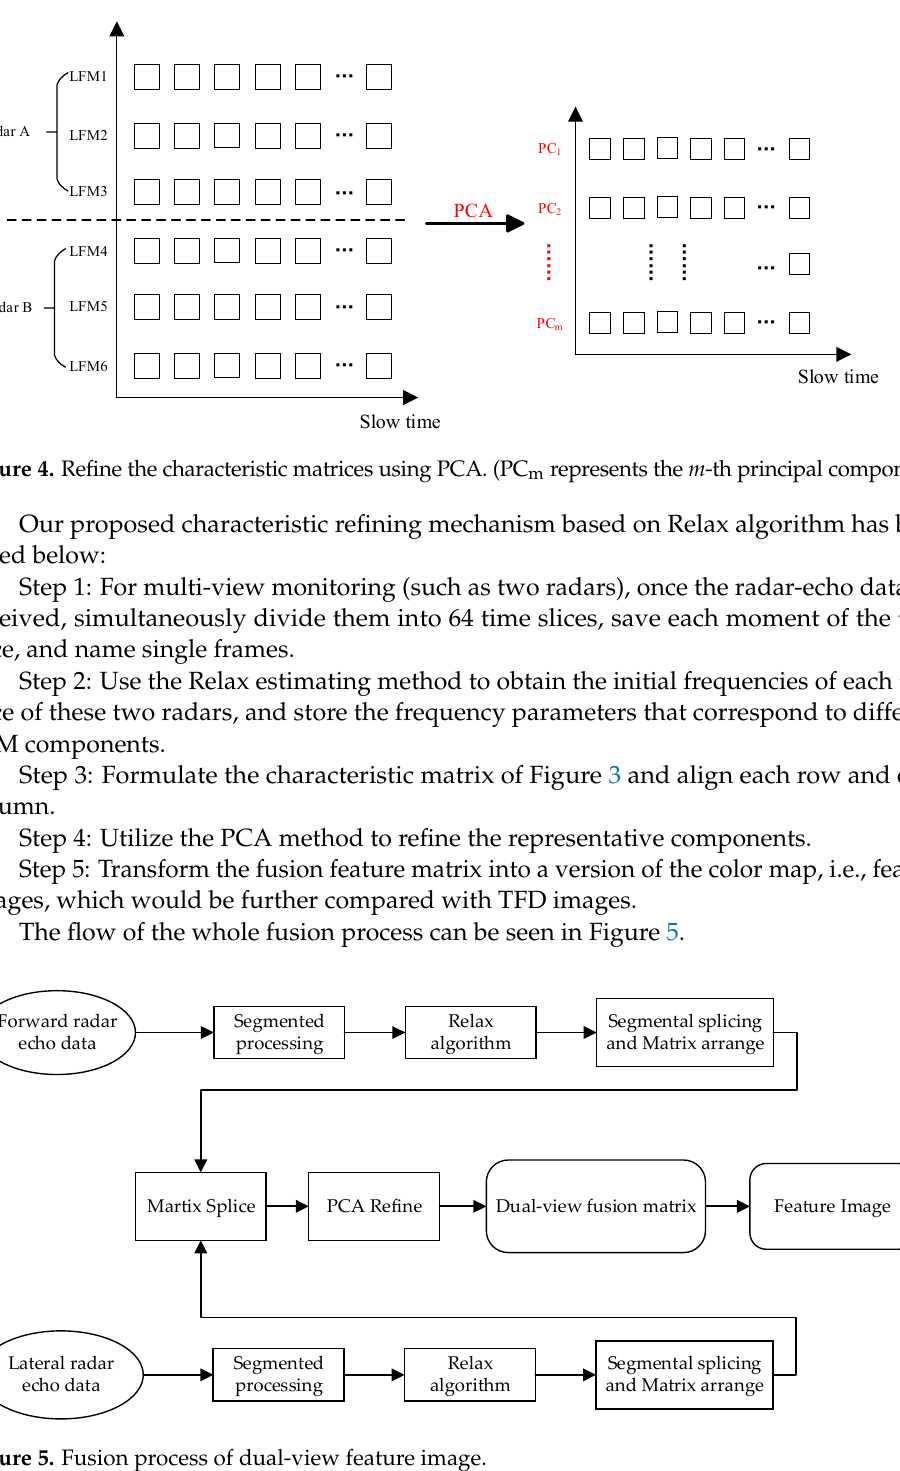
Figure 6. Basic structure of convolution neural network.